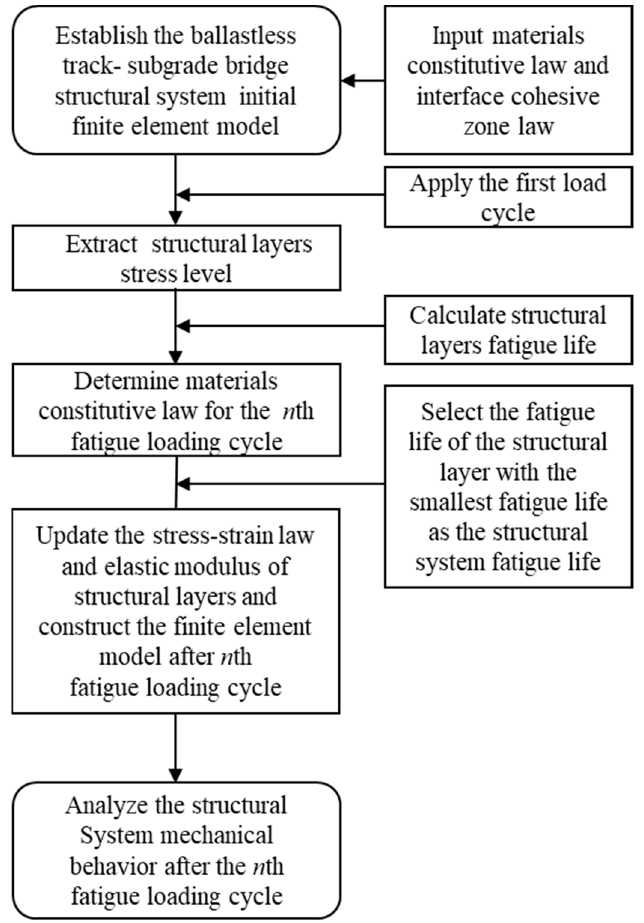
Figure 5. Flow chart of equivalent static analysis for structural system under fatigue loading.